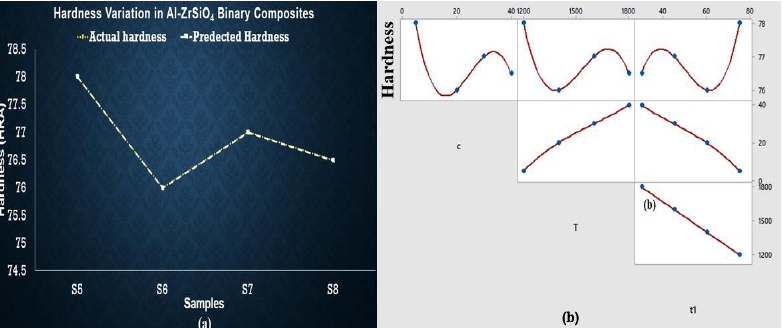
Figure 5. ( a ) Regression plot for Al-SiC showing overlapping of actual and predicted hardness val- ues points (yellow dotted line presents actual value of hardness and white line shows predicted values). ( b ) Matrix plot showing the individual relationship between hardness and input variables for Al-SiC.